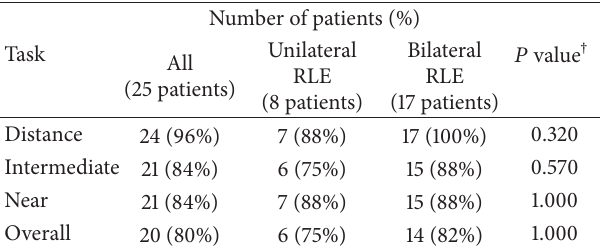
Table 3: Spectacle independence at 6